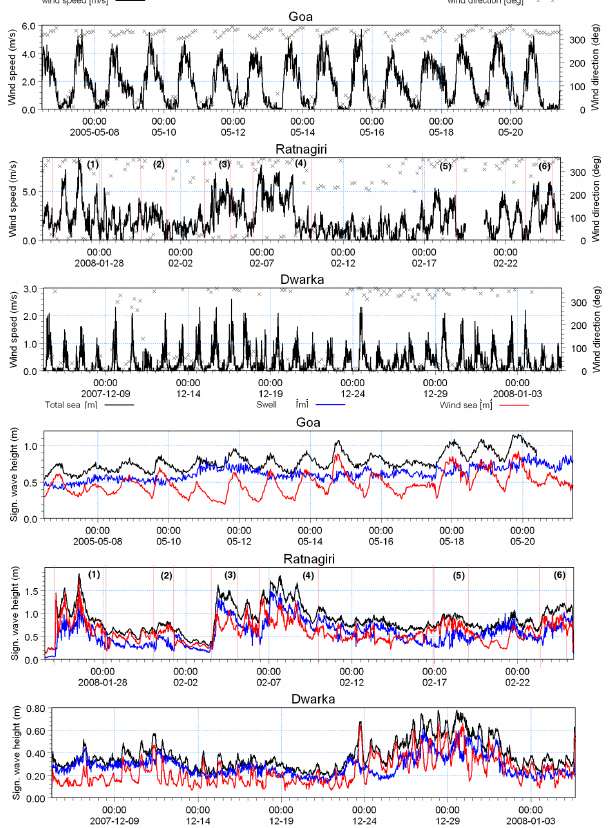
Fig. 3. Typical 1-D spectra measured off (a) Goa during 9 May 2005, (b) Ratnagiri during 3 February 2008 and (c) Dwarka during 22 December